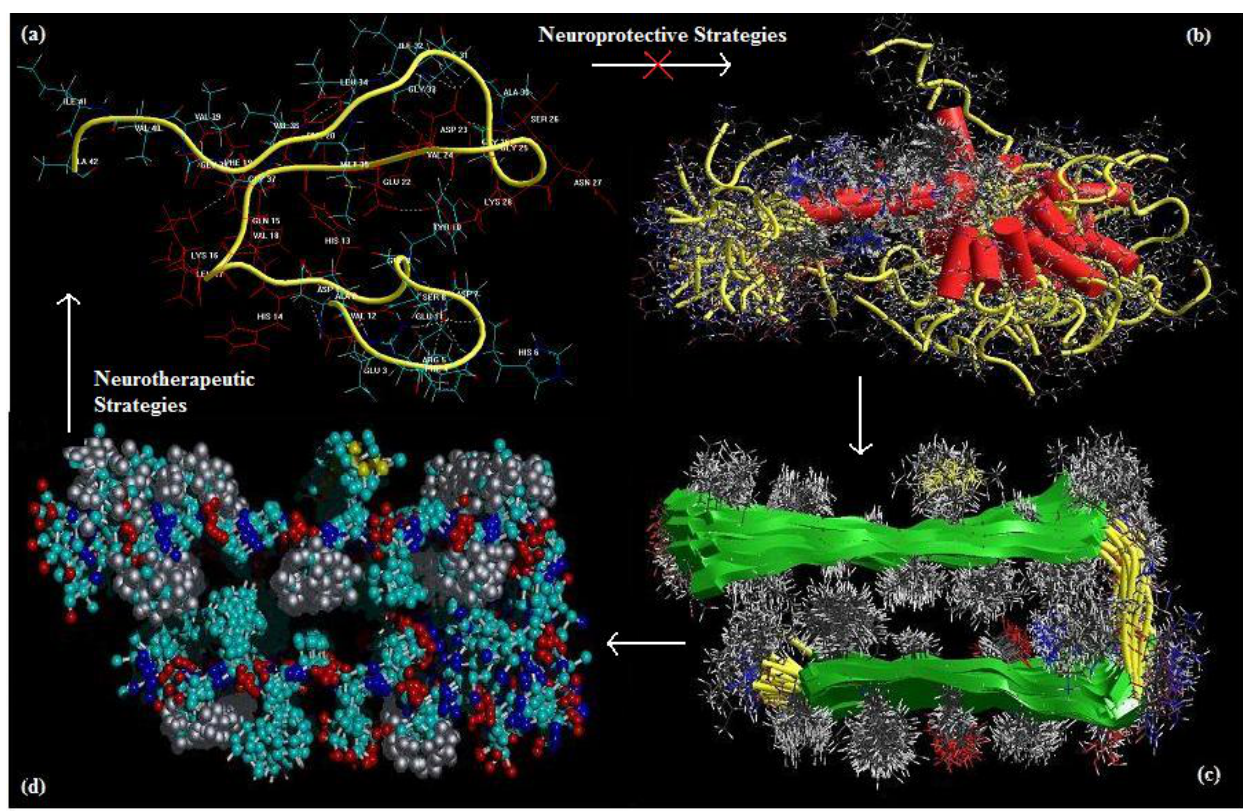
Figure 1. Hierarchical self-assembly of amyloid β-protein ( a ) amyloid-β protein oligomer; ( b ) proto-fibril; ( c ) fibril; and ( d ) plaque